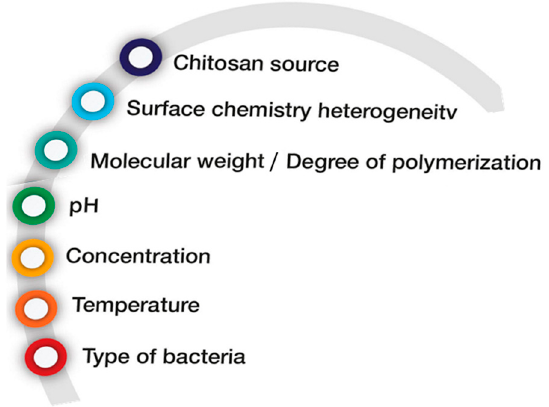
Figure 2. Intrinsic and external factors influencing the antibacterial activity of